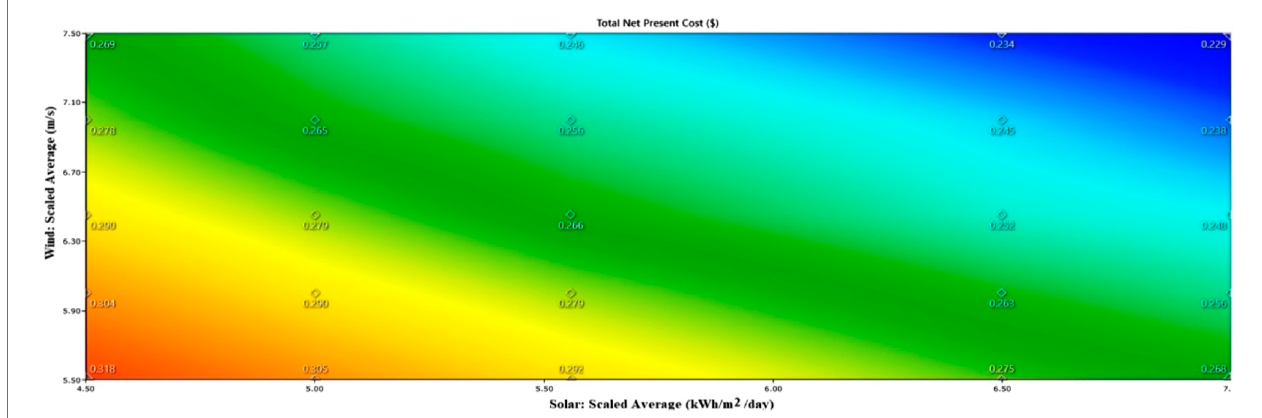
FIGURE 15 | Sensitivity analysis: solar radiation vs. wind speed. Surface plot: NPC, superimposed: COE.